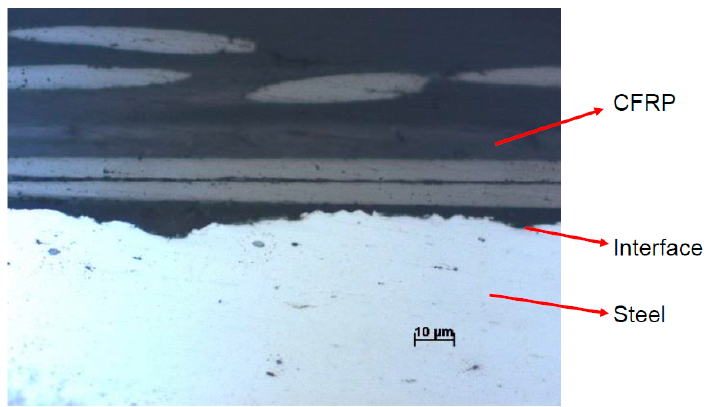
Figure 6. Cross-sectional view highlighting the microstructure of the CFRP / steel hybrid component in direct vicinity of the interface of both materials.